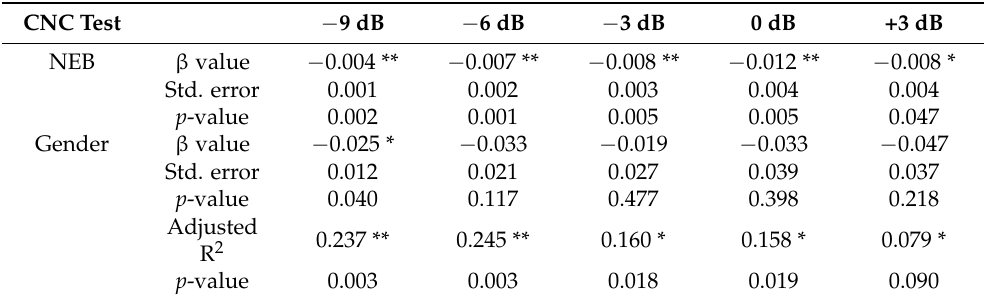
Table 5. Results of the regression analyses listing predictors for performances in the CNC test at 5 SNRs.